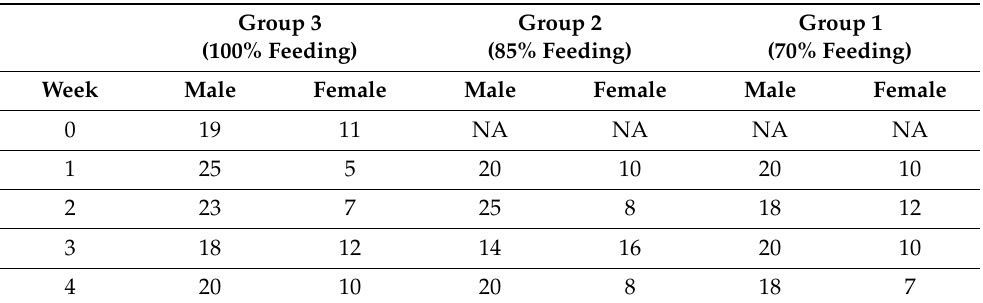
Table 1. The number of male and females represented in the three treatment groups at weekly intervals. Group 3 (100% Feeding)